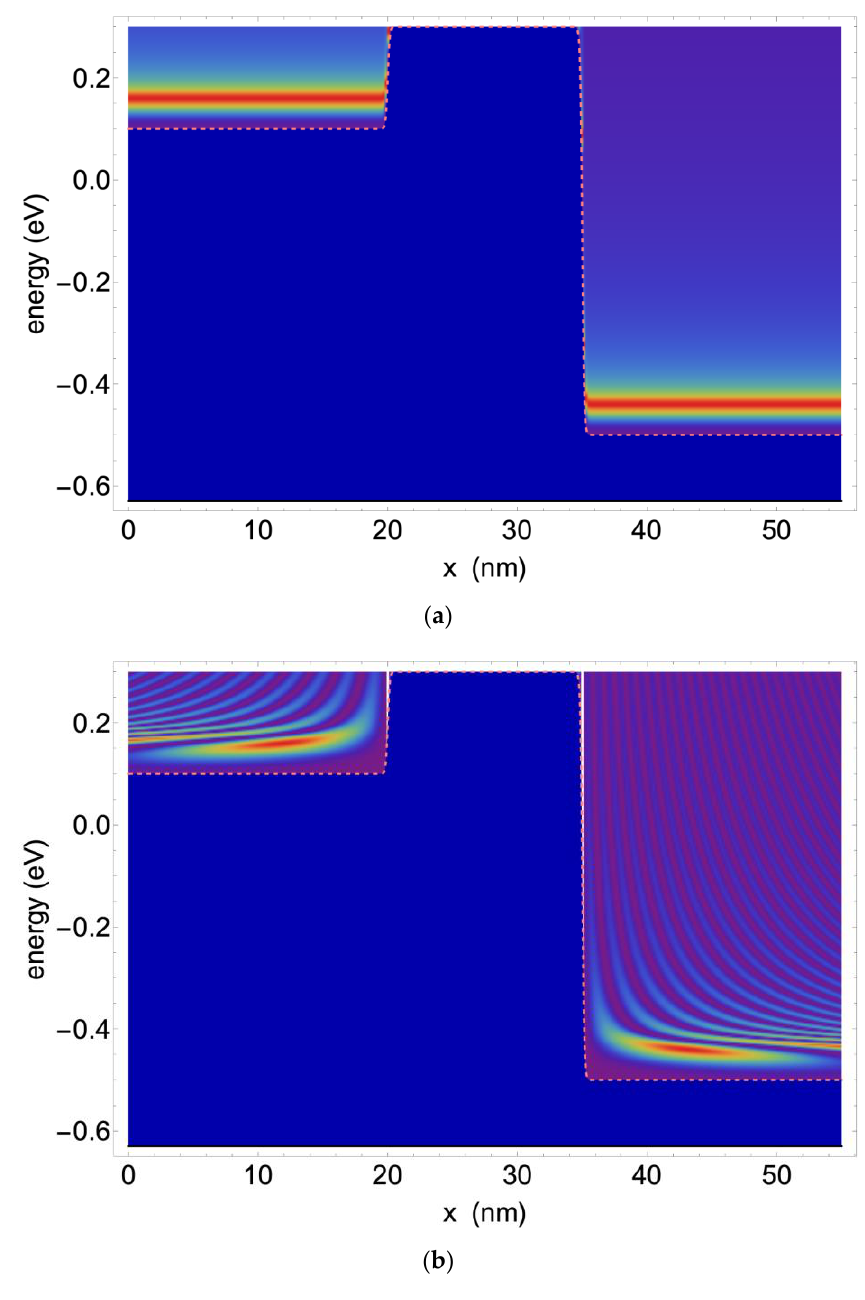
Figure A1. LDOS for a silicon nanowire-FET (NWFET) simple device potential profile (dashed pink line) ( a ) classical result; ( b ) quantum result showing influence of strong reflections on either side of the barrier.